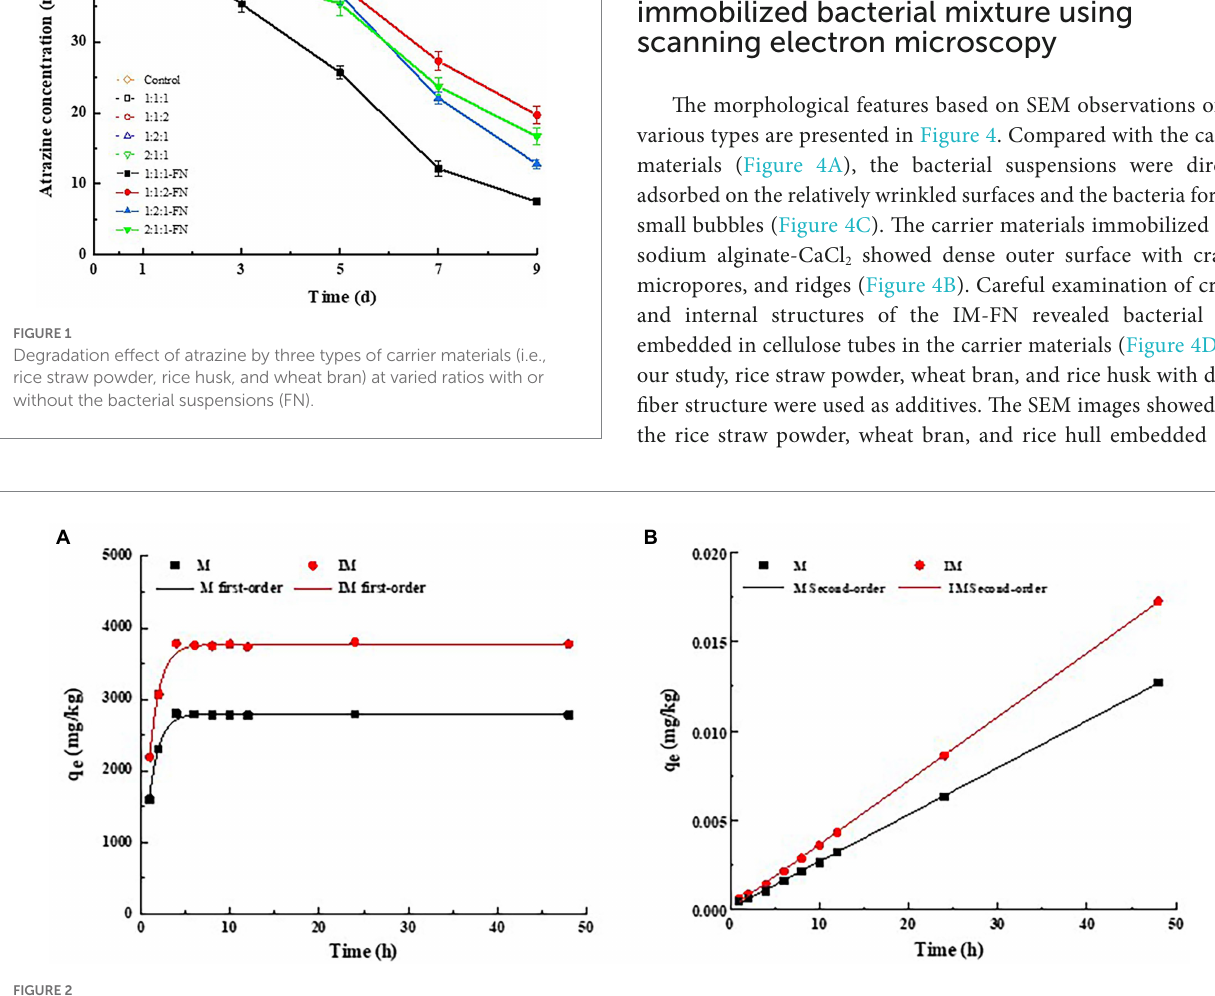
FIGURE 2 Adsorption pseudo-first-order kinetics (A) and pseudo-second-order kinetics plots fitting of t / qt (B) of atrazine on carrier materials (M) and immobilized carrier materials (IM).